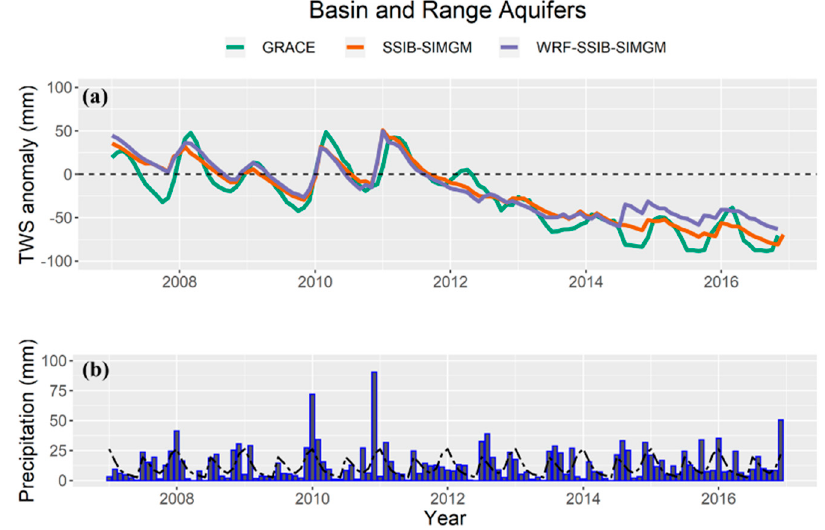
Figure 4. ( a ) GRACE, SSIB-SIMGM, and WRF-SSIB-SIMGM monthly TWS anomalies based on the 2007–2010 baseline and ( b ) monthly precipitation for the Coastal Basin aquifer system between 2007 and 2016. Dashed line in ( b ) represents an average precipitation annual cycle over the aquifer. Table 2. SSIB-SIMGM and WRF-SSIB-SIMGM performances for the Coastal and Basin and Range aquifer systems. Includes the average bias, root-mean-squared error (RMSE) (mm/month), and temporal correlation (TCOR). All correlation coefficients are significant at a 99% confidence interval. Aquifers Data Coastal Basin